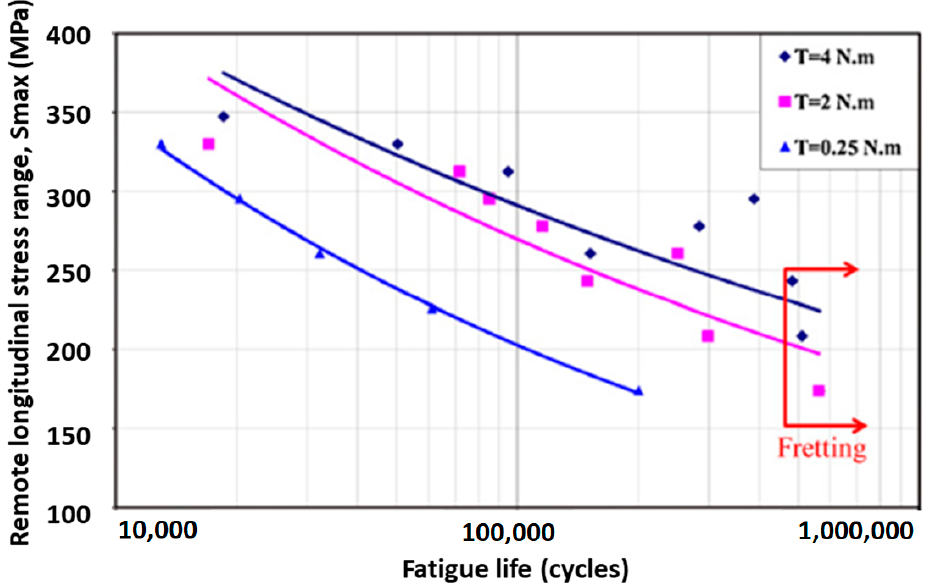
Figure 16. S-N curve for the double shear lap joint at different torque levels (4 N · m, 2 N · m and 0.25 N · m) without lubrication [107].